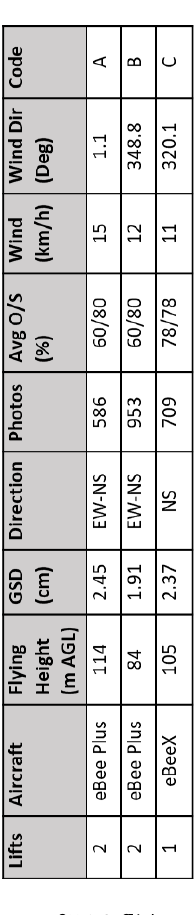
Table 2. Summary of UAS flight campaign